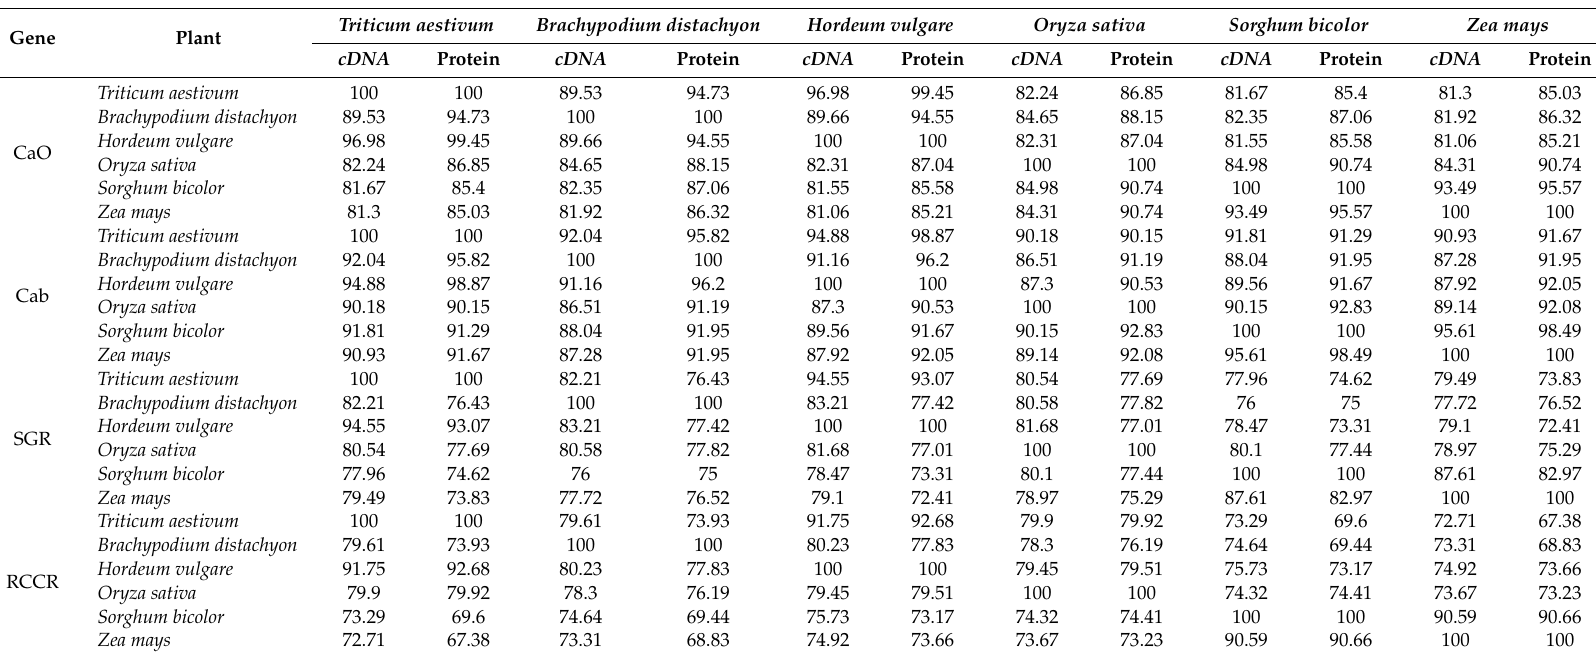
Table 1. Homology in the coding regions and amino acid sequences of chlorophyllide a oxygenase (CaO), light-harvesting complex (Cab), stay-green (SGR), and